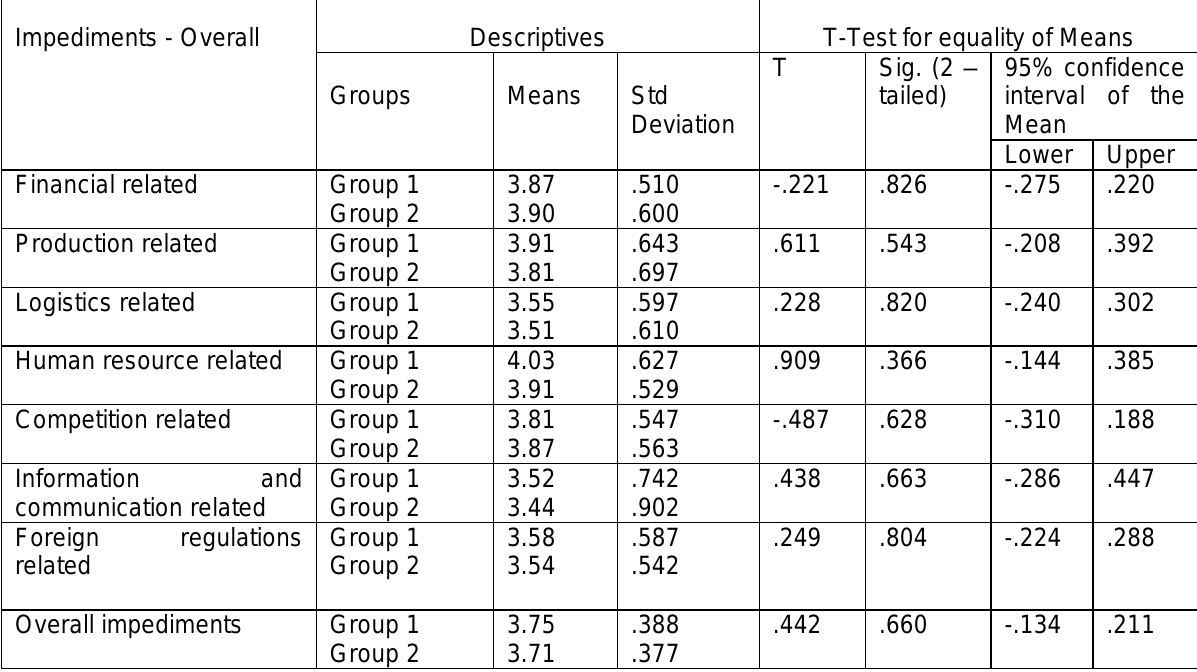
Table 4: Independent Sample t-test - Those who investigated/discussed the idea of exporting (group 1) and those who did not (group 2) Impediments -